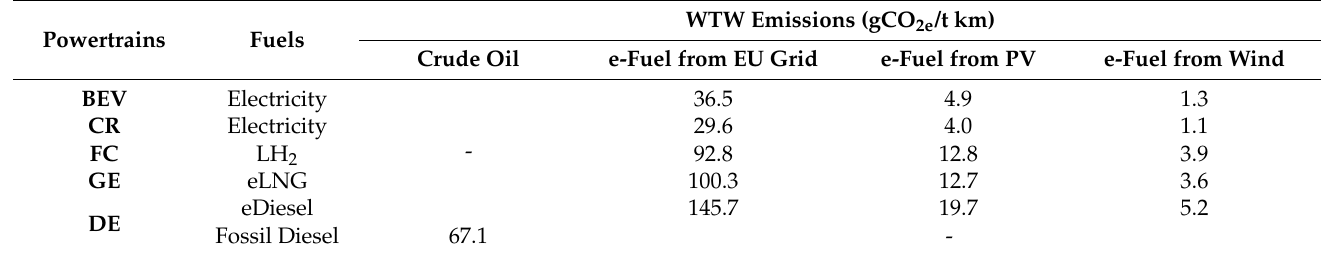
Table 6. Resulting WTW emissions (gCO 2e /tonne km) for the selected fuel–powertrains couples.